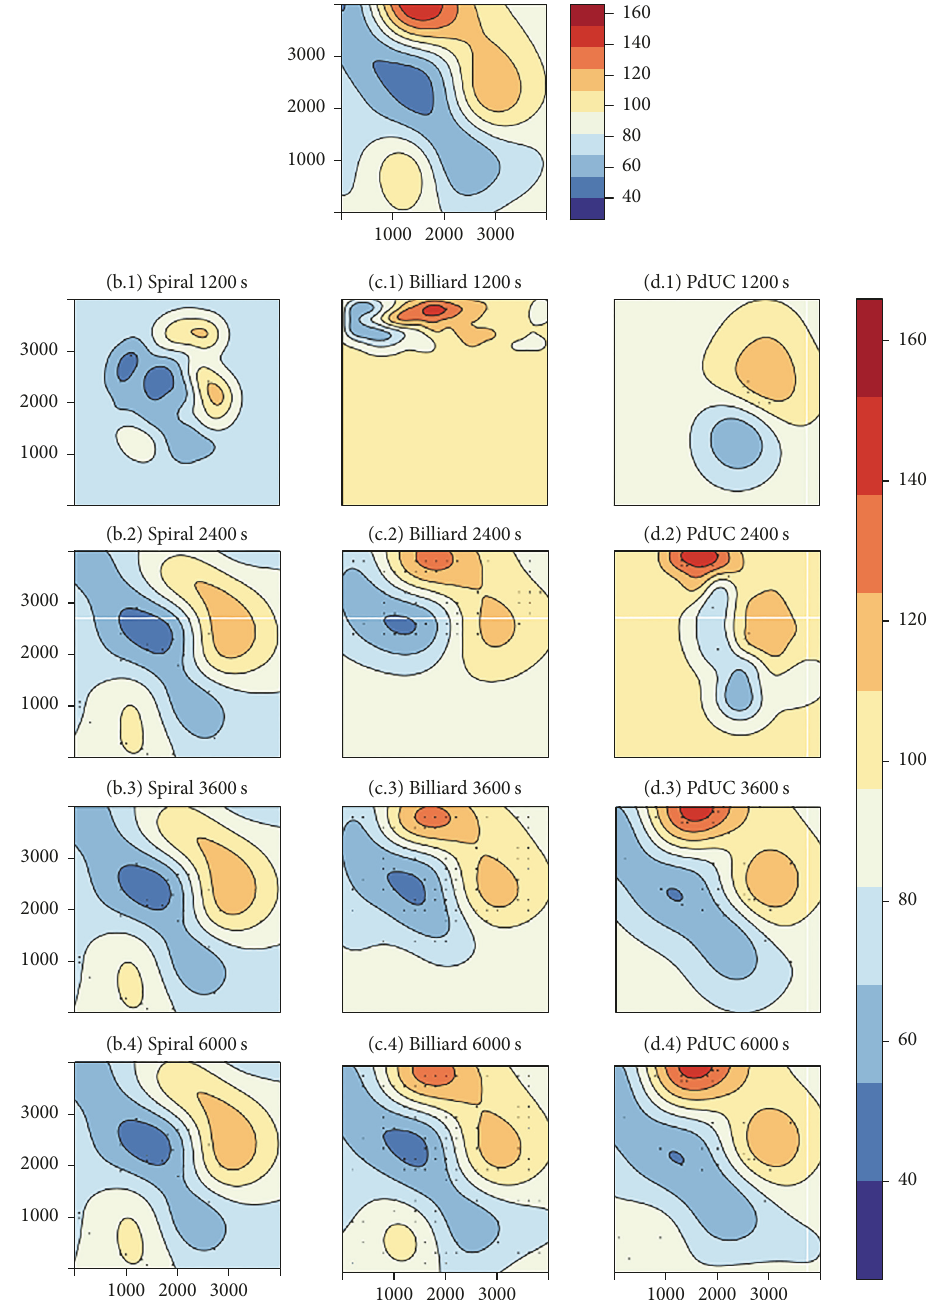
Figure 15: Visual representation of the estimation output for the PdUC, Billiard, and Spiral mobility models at different times.